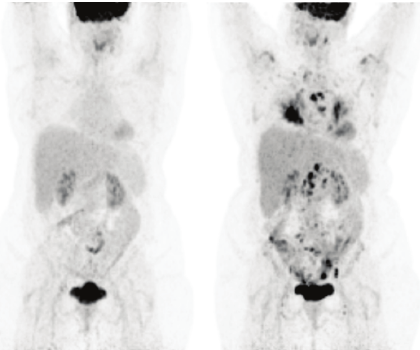
monthly dose of 5 mg/kg bodyweight accompanied by a low dose of methotrexate (7.5 mg/week).